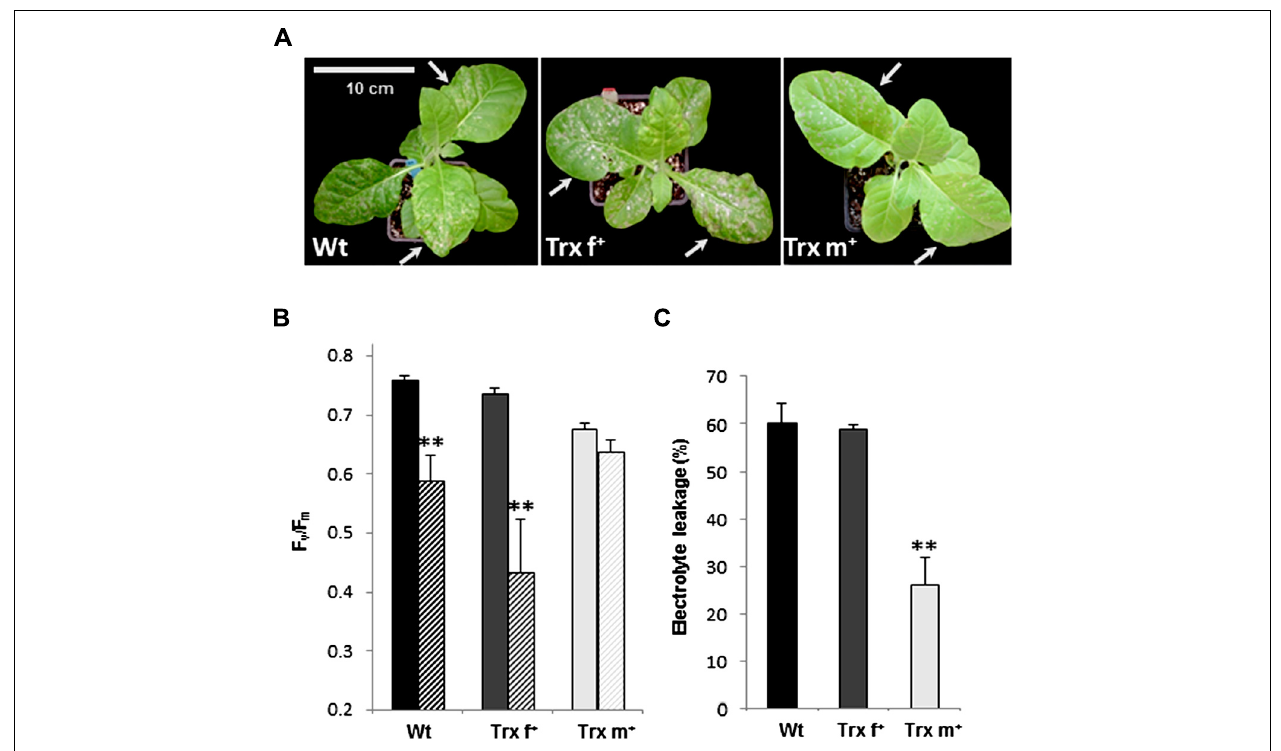
FIGURE 7 |Tolerance to methyl viologen of transplastomic tobacco plants overexpressingTrx f orTrx m. 40-day old tobacco plants were sprayed with 30 μ M MV and grown in a controlled growth chamber as described in Section “Materials and Methods.” (A) Visual symptoms 2 days after treatment. Photographs show representative plants subjected to the treatment. (B) Maximal photosystem II photochemical efficiency in tobacco plants. F v / F m values were measured in plants grown in control conditions (full bars) and in plants subjected to MV treatment for 5 h (dashed bars). Data are mean values ± SD from six plants per genotype. Measurements were